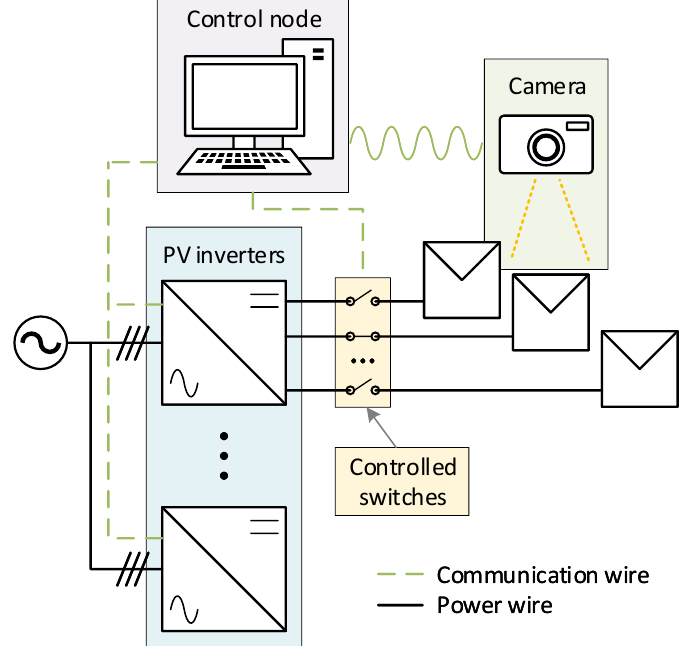
Figure 4. Proposed communication scheme for the implementation of EL maintenance technique in